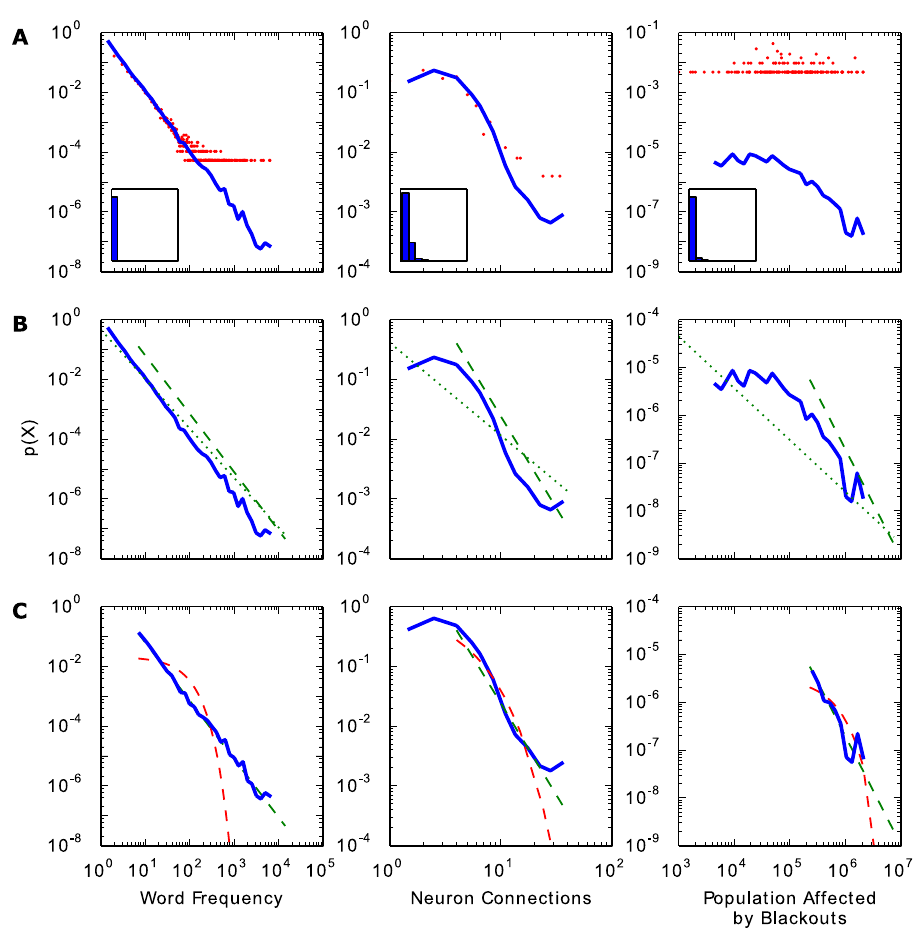
Figure 1. Basic steps of analysis for heavy-tailed distributions: visualizing, fitting, and comparing. Example data for power law fitting are a good fit (left column), medium fit (middle column) and poor fit (right column). Data and methods described in text. a) Visualizing data with probability density functions. A typical histogram on linear axes (insets) is not helpful for visualizing heavy-tailed distributions. On log-log axes, using logarithmically spaced bins is necessary to accurately represent data (blue line). Linearly spaced bins (red line) obscure the tail of the distribution (see text). b) Fitting to the tail of the distribution. The best fit power law may only cover a portion of the distribution’s tail. Dotted green line: power law fit starting at x min =1. Dashed green line: power law fit starting from the optimal x min (see Basic Methods: Identifying the Scaling Range). c)